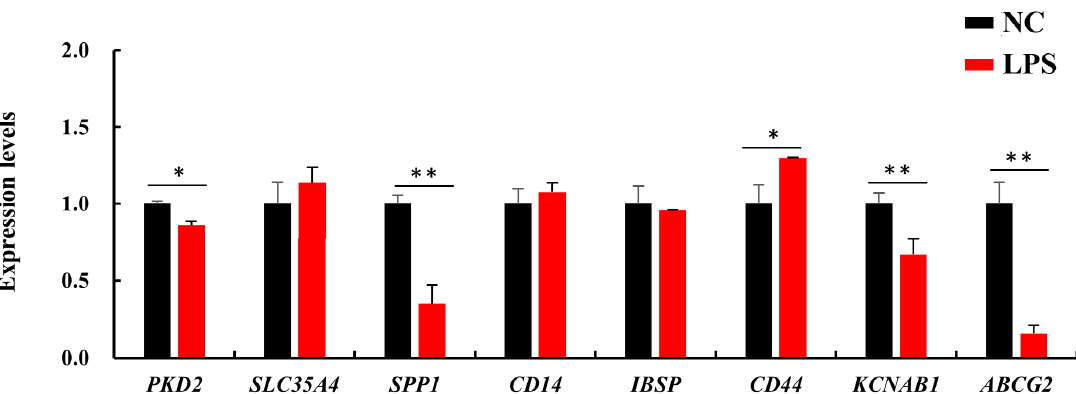
Figure 7. The relative expressions of candidate genes in LPS-challenged bMECs. Standard errors are indicated by bars, and significant probability values are those with * p < 0.05 and ** p < 0.01.